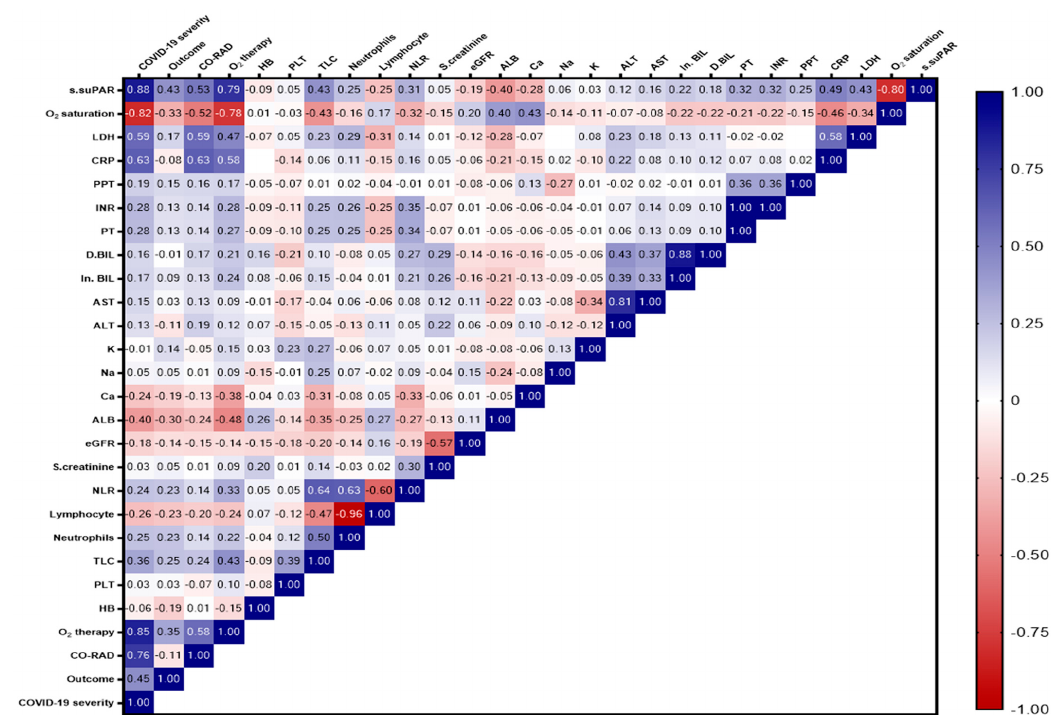
Figure 3. Correlation matrix showing the interrelationship between suPAR level and the different study variables. The blue color indicates a positive correlation, and the red color indicates a negative correlation. The value of r indicates the degree of association. Signi fi cance was set at p < 0.05.